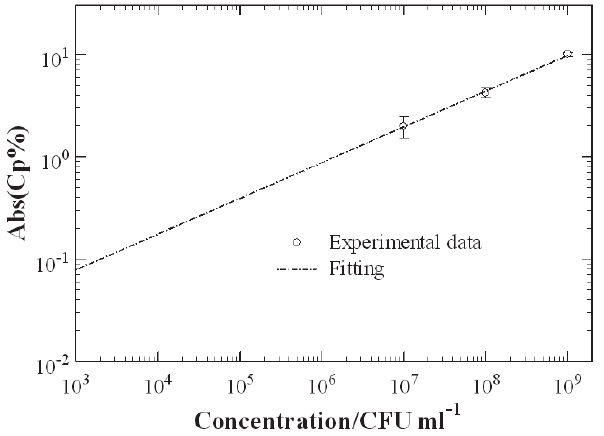
Fig.6: Dependence of C p % with the yeast cells